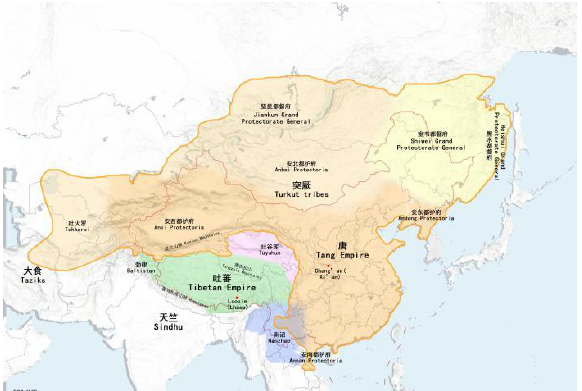
Figure 2. Peripheral environment of early Tubo Kingdom